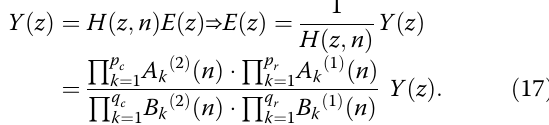
p ffiffiffiffiffiffiffiffiffiffiffiffi P − ð n Þ